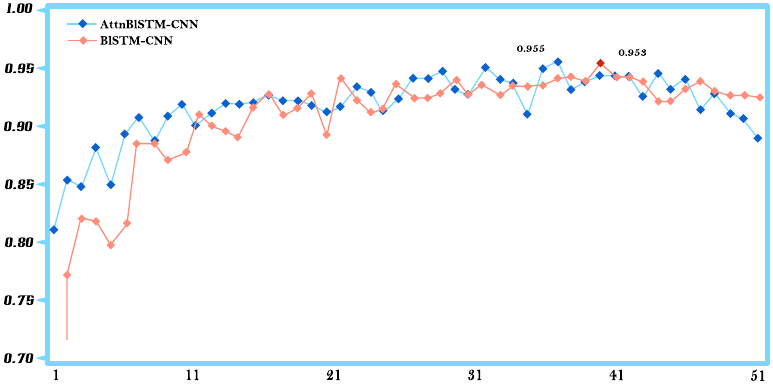
Figure 10. Fifty-iteration accuracy results of AttnBiLSTM-CNN and BiLSTM-CNN.